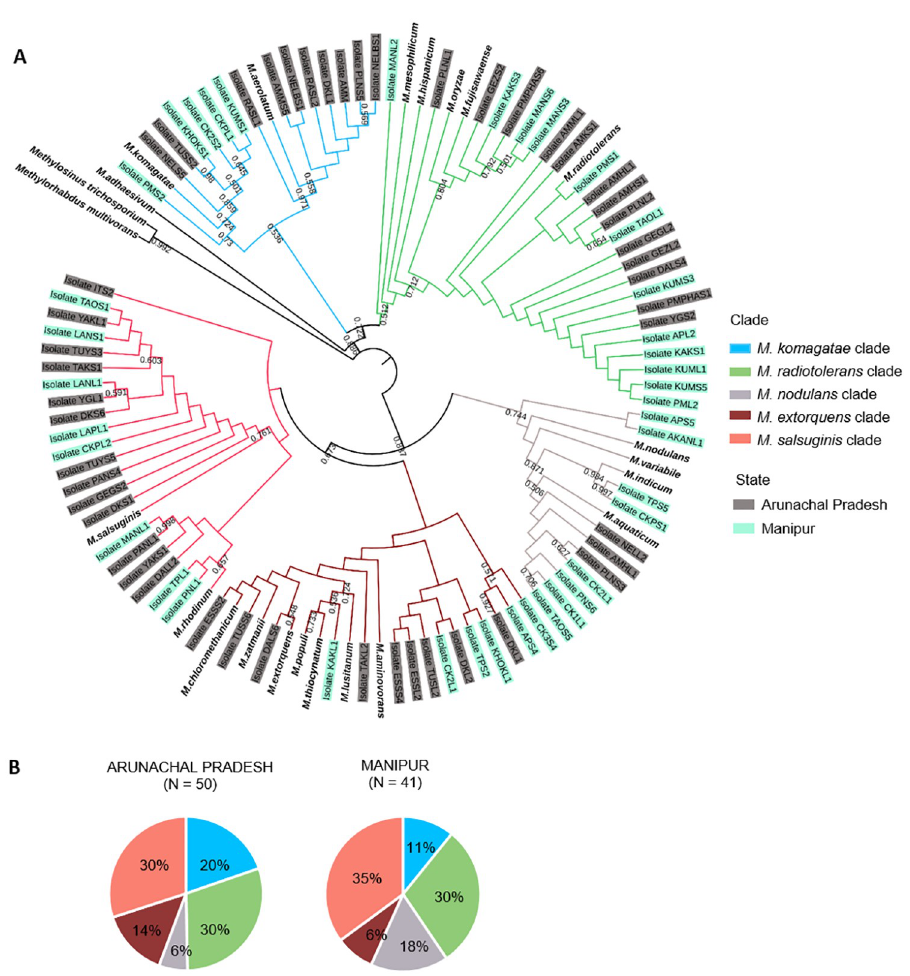
Fig 2. Phylogenetic relationships between rice-associated Methylobacterium isolates. (A) Neighbor-joining tree constructed from the 16S rRNA gene sequences of 91 distinct Methylobacterium isolates from rice landraces (colored by sampling state), and closely related reference strains (in bold). Bootstrap values � 50% are indicated. We delineated five clades based on the tree (branches are colored as indicated). (B) Piecharts showing the clade composition of Methylobacterium isolates from each